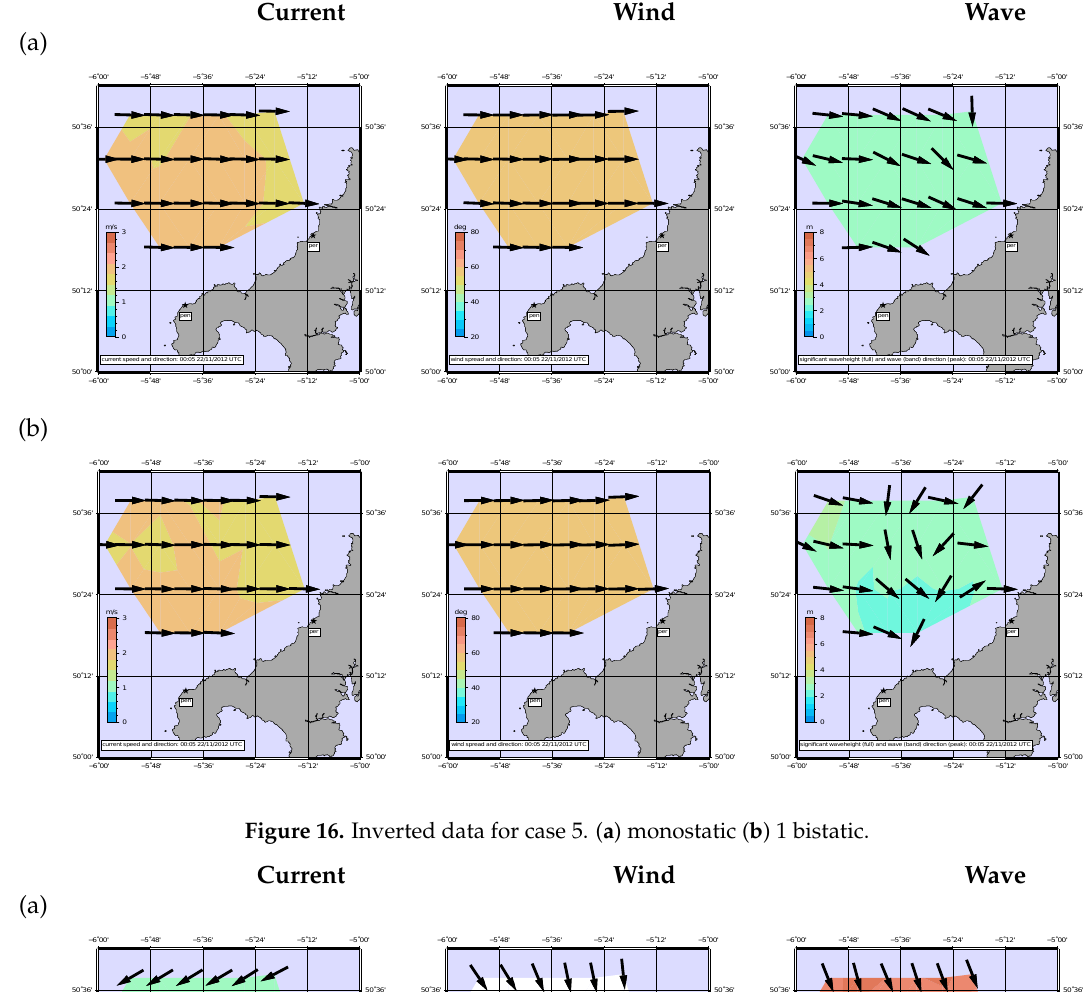
Figure 16. Inverted data for case 5. ( a ) monostatic ( b ) 1 bistatic. Current Wind Wave